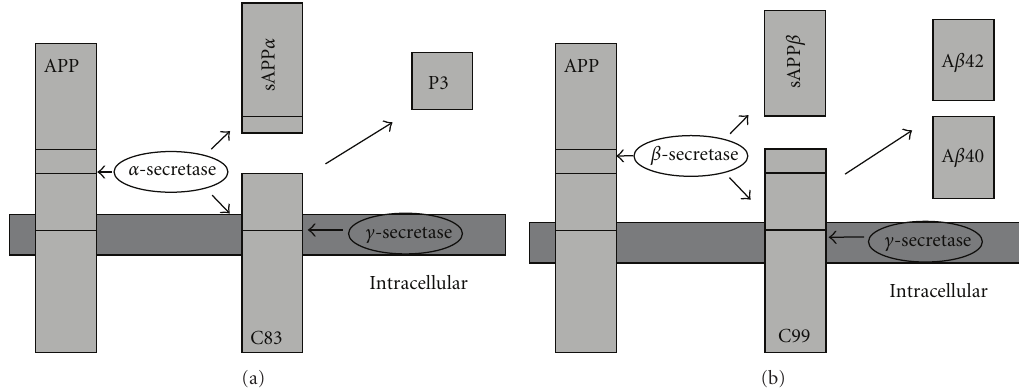
Figure 4: APP cleavage. (a) Nonamyloidogenic pathway: APP is cleaved by α -secretase leading to a membrane-bound C83 ( α c-terminal fragment, α CTF) and the soluble APPs α ; (b) amyloidogenic pathway: APP is cleaved via the β -secretase (BACE-1) and γ -secretase (presenilin complex). β - and subsequent γ -cleavage of APP leads to generation of β -amyloid 40 / 42 (A β ). Abbreviations: APP, amyloid precursor protein; A β , β -amyloid; BACE, β -site cleavage